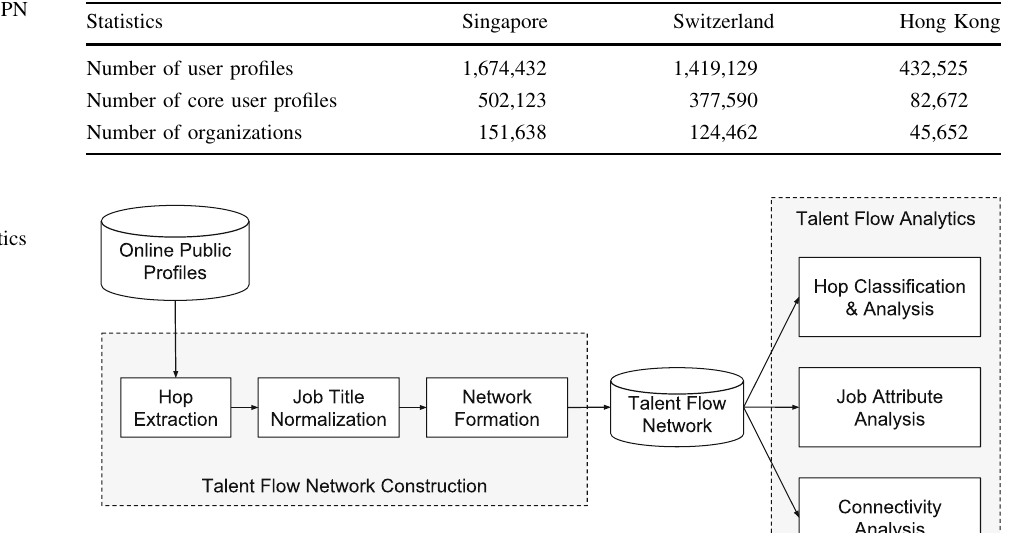
Table 1 Statistics of the OPN datasets used in this